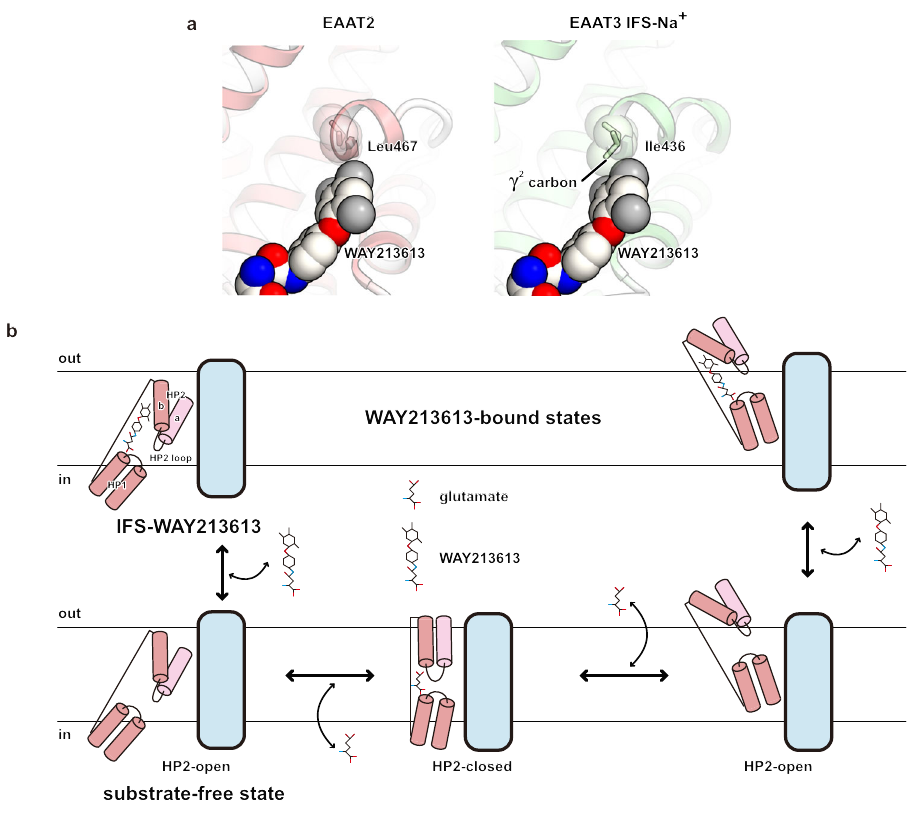
Fig. 6 | Inhibition mechanism by WAY213613. a Close-up view of the IFS- WAY213613 state and molecular superposition of EAAT3 IFS-Na + . WAY213613, Leu467, (HsEAAT2) and Ile436 (EAAT3) are shown as CPK models. b In the HP2- open con fi guration of the outward-facing state, extracellular glutamate is